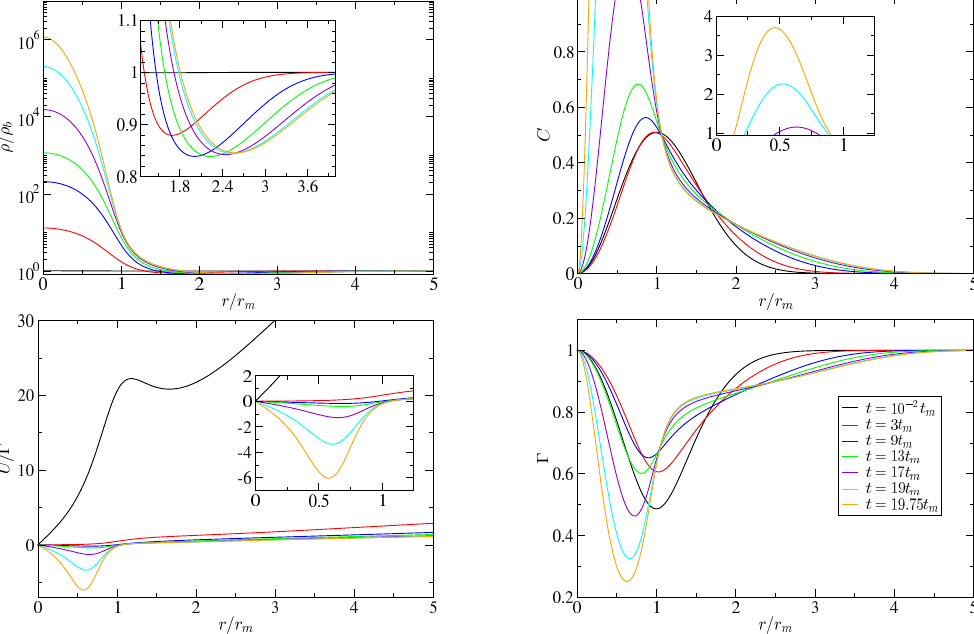
Figure 7. Dynamics of different magnitudes in the case of a supercritical fluctuation (Gaussian profile) at given times t . In particular, δ m = 0.51 and δ c = 0.49774 ± 2 × 10 − 5 .